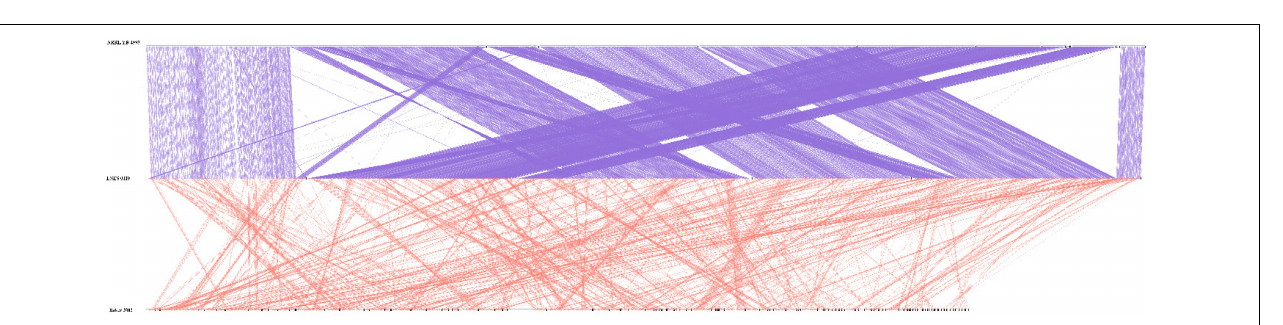
FIGURE 5 | Parallel collinearity comparison between three M. bicuspidata strains LNES0119, NRRL YB-4993, and Baker